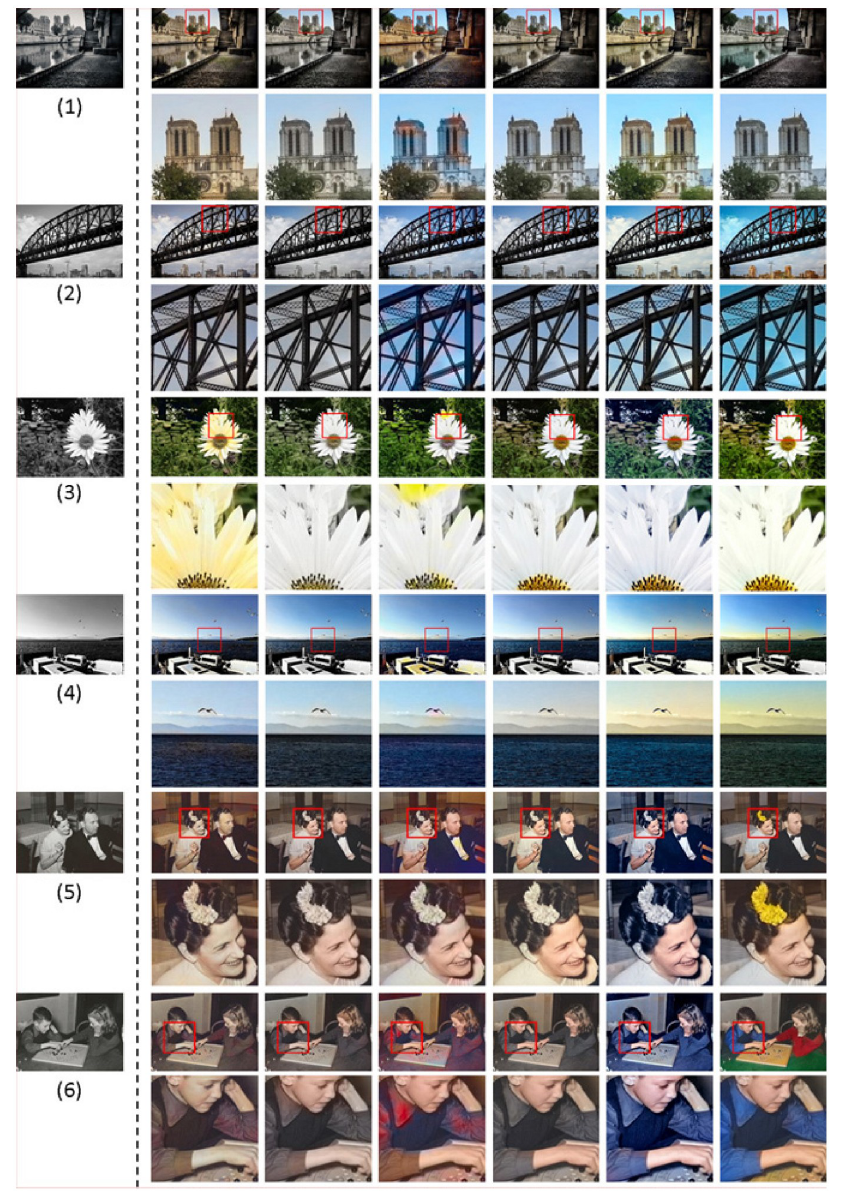
Fig 8. Color restoration of black-and-white images. (a) GT, (b) [16], (c) [17], (d) [18], (e) [47], (f) [48], (g) Ours.